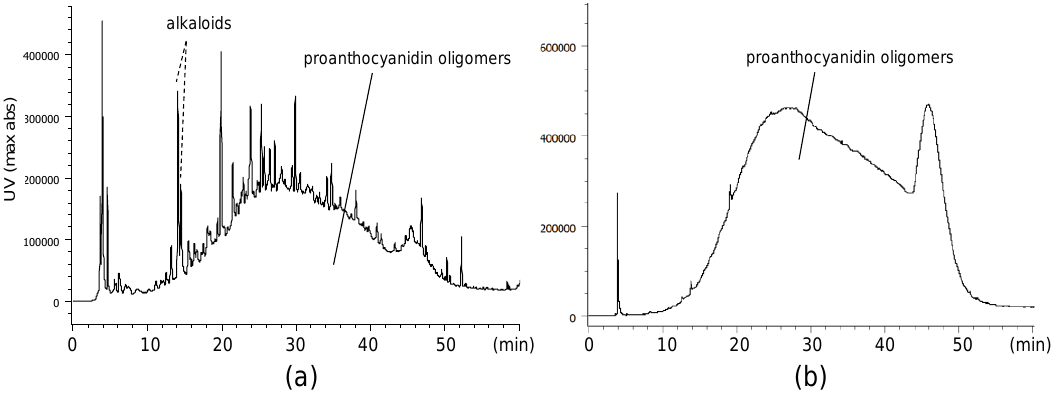
Figure 1. HPLC profiles of 60% EtOH extract of E. sinica ( a ) and proanthocyanidin oligomer fraction ( b ).